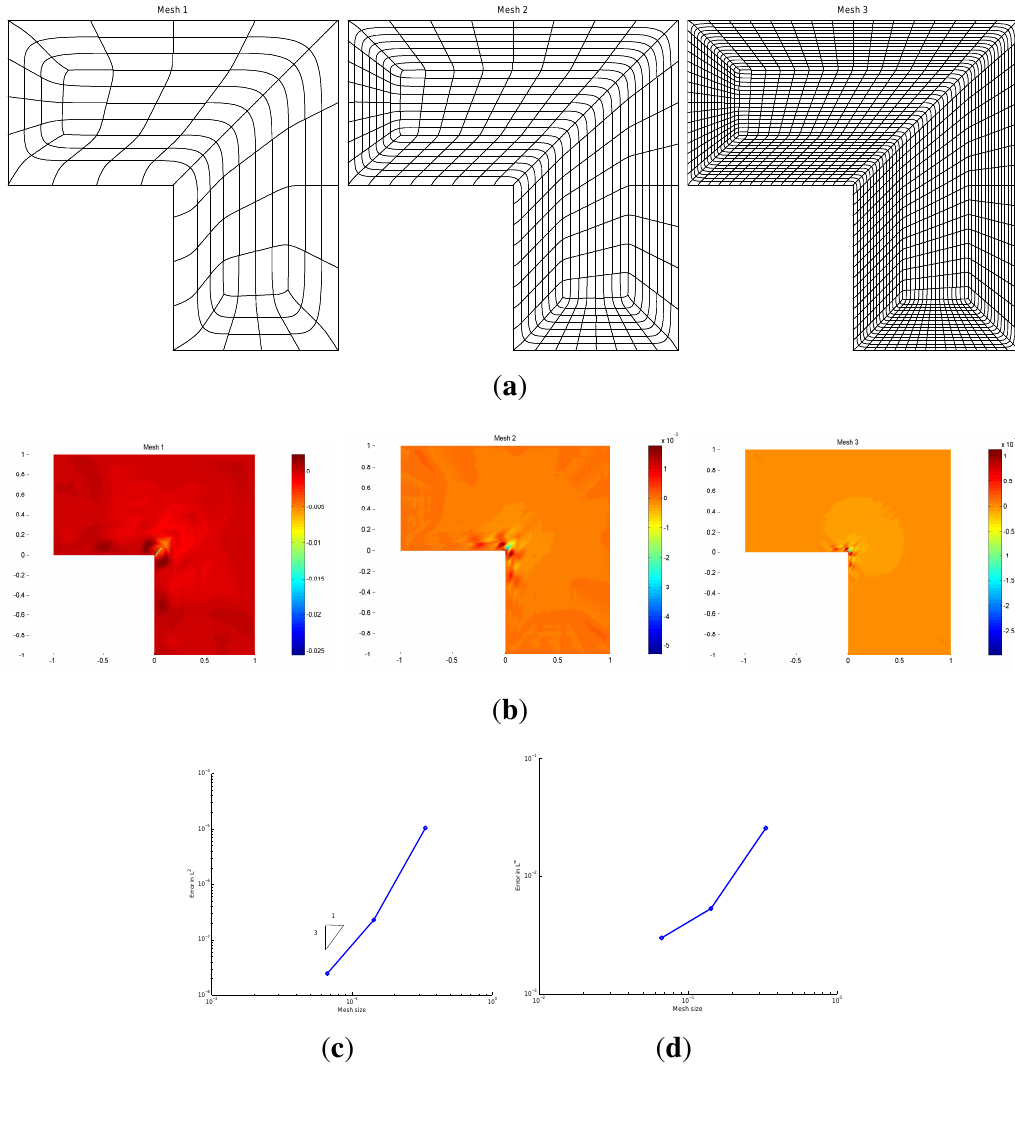
Figure 12. The G 1 bi-3/bi-5solution of Laplace’s equation on the L-shape. ( a ) h -refinement of the L-shape; ( b ) the difference between the exact solution and the computed solution; ( c ) L 2 -error; ( d ) L ∞